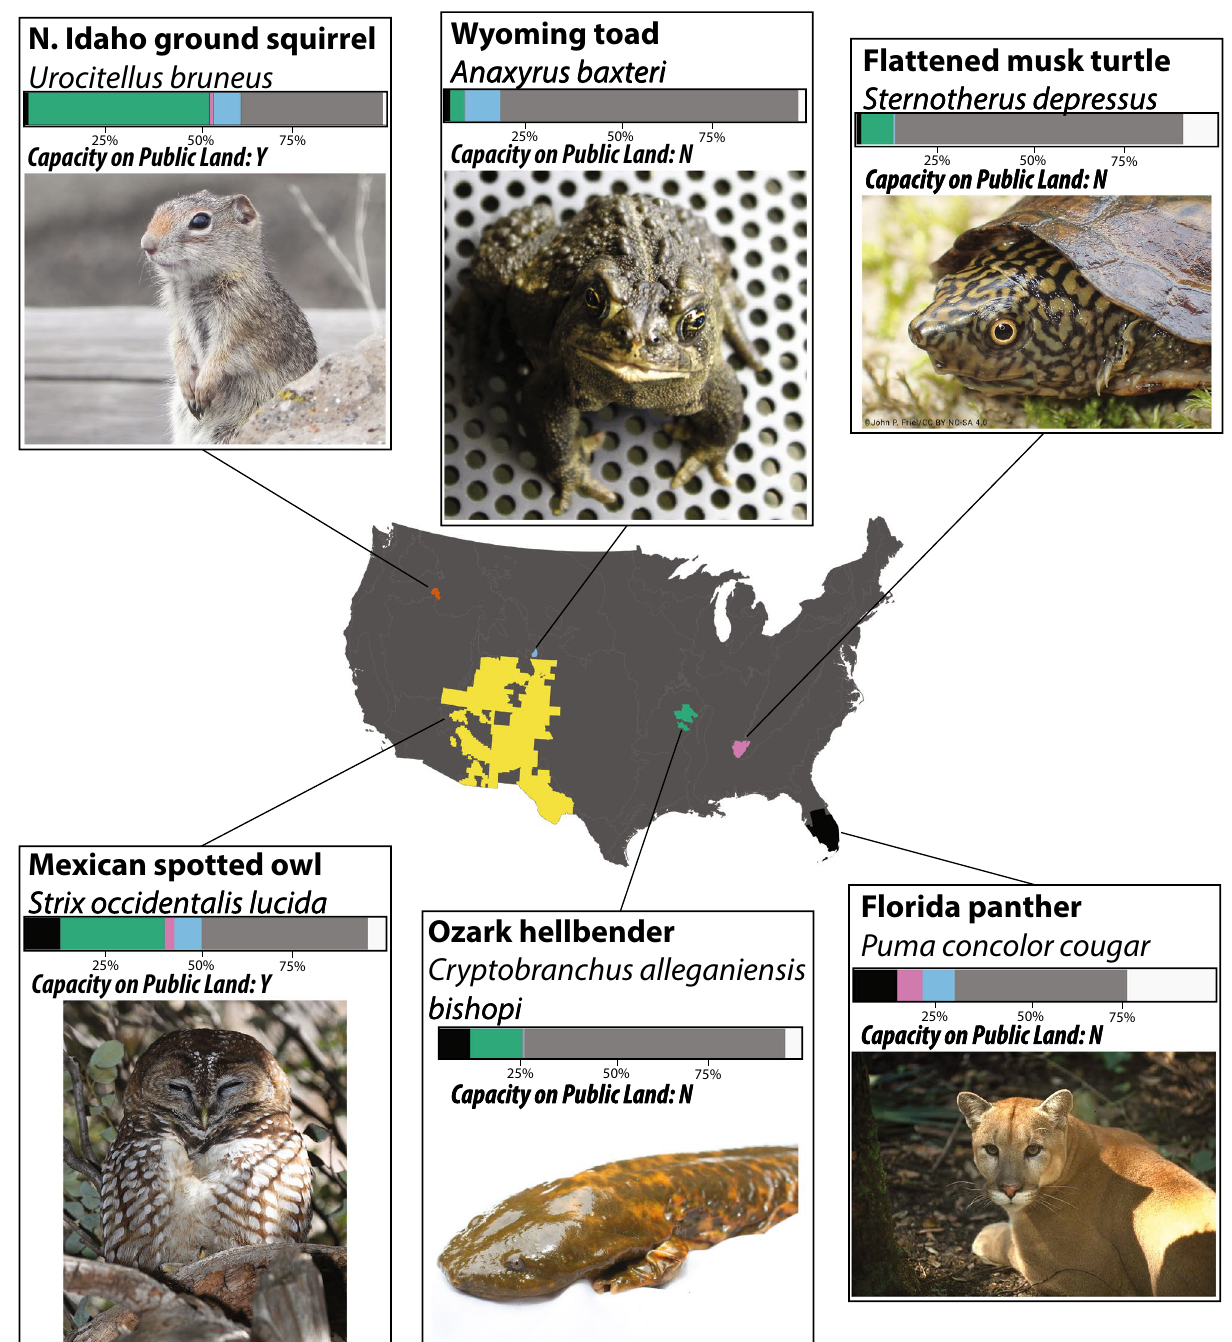
Figure 3. Examples of endangered species that would benefit from different combinations of public and private land conservation. Map colors show species’ ranges; Urocitellus bruneus: orange , Anaxyrus baxteri : blue, Sternotherus depressus : pink, Strix occidentalis lucida: yellow, Cryptobranchus alleganiensis bishop : green, Puma concolor cougar : black. Bar graphs indicate the percent of species ranges within each type of